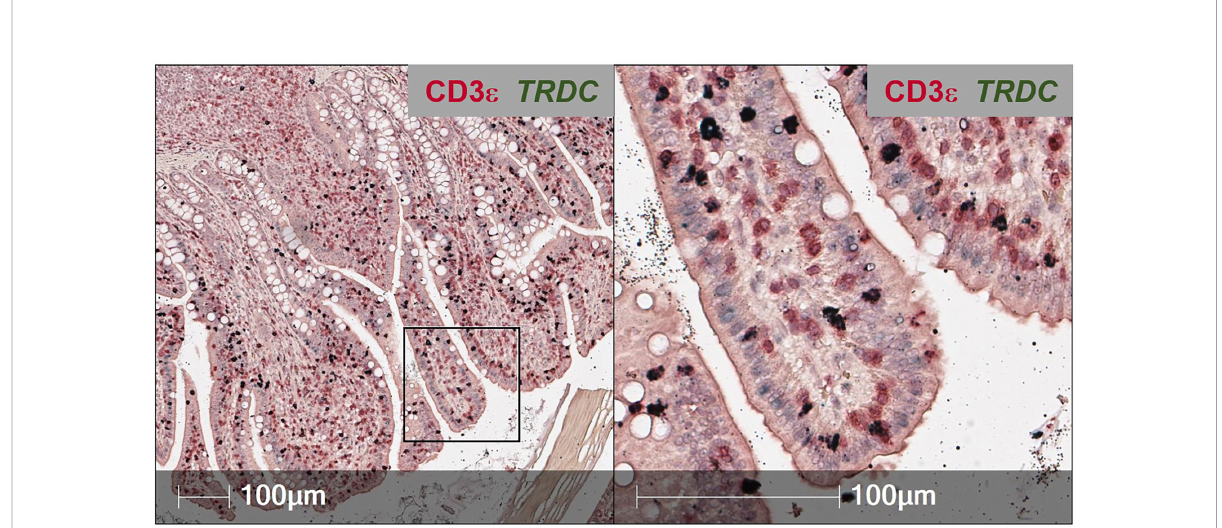
FIGURE 3 Dual in situ detection of ab and gd T cells in pig intestine. Section of ileum from a ~6-week-old pig stained for CD3 e protein (red) and TRDC transcript (dark green). TRDC + cells (dark green) are identi fi ed as gd T cells, while TRDC - CD3e + cells (red) are identi fi ed as ab T cells. The staining protocol was further optimized from previous work (57, 66) and is available at